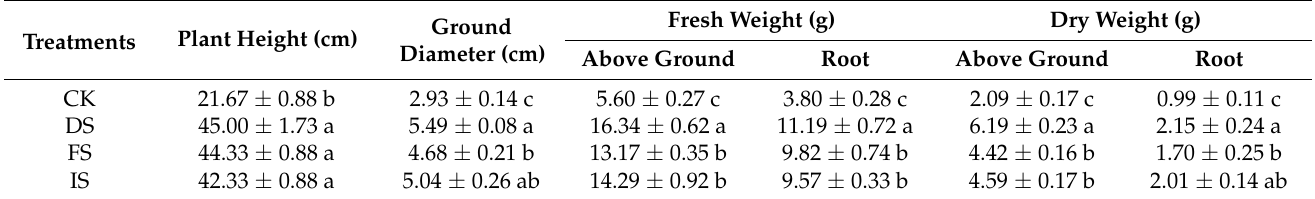
Table 2. Effects of different forms of T . erecta biofumigation on the biomass of M. hupehensis seedlings.